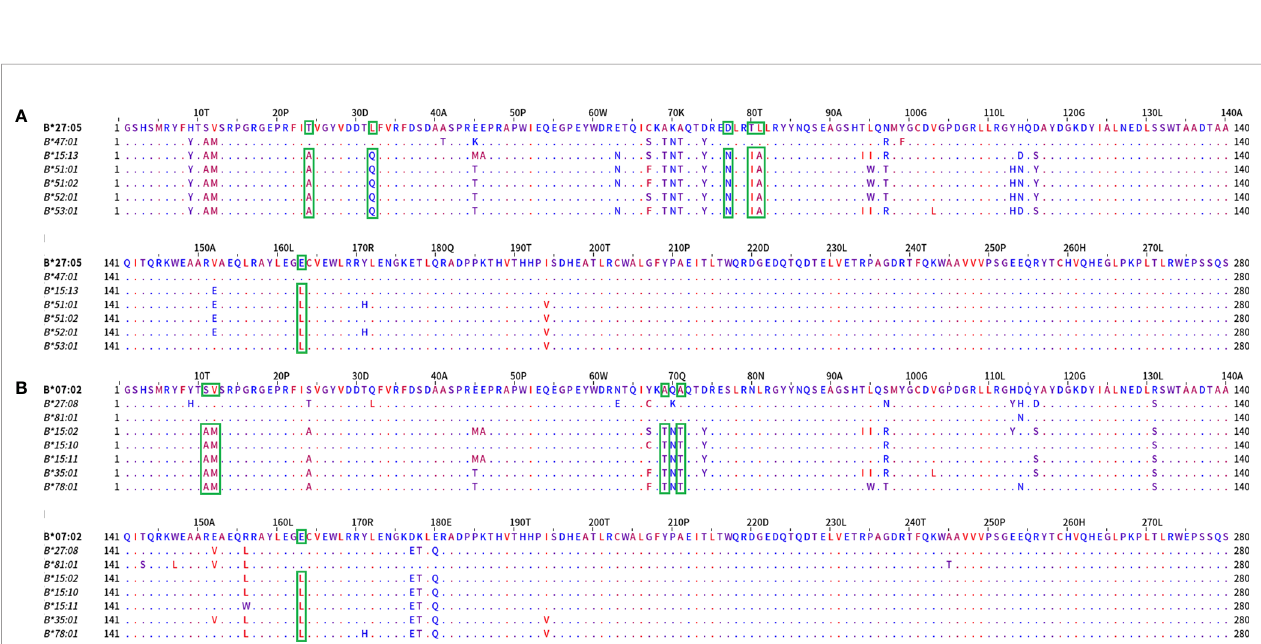
FIGURE 4 | PCA biplot projections of the anti-HLA- b antibody response. Panel (A) on the left represents the de fi ned plane of the fi rst and second principal components while Panel (B) on the right represents the second and third principal components de fi ned plane. The points represent projections of individual reactions and arrows the different anti-HLA-B responses. The color vectors on the right side of both panels represent the cos2 value of the explained variance for variables and individuals respectively.